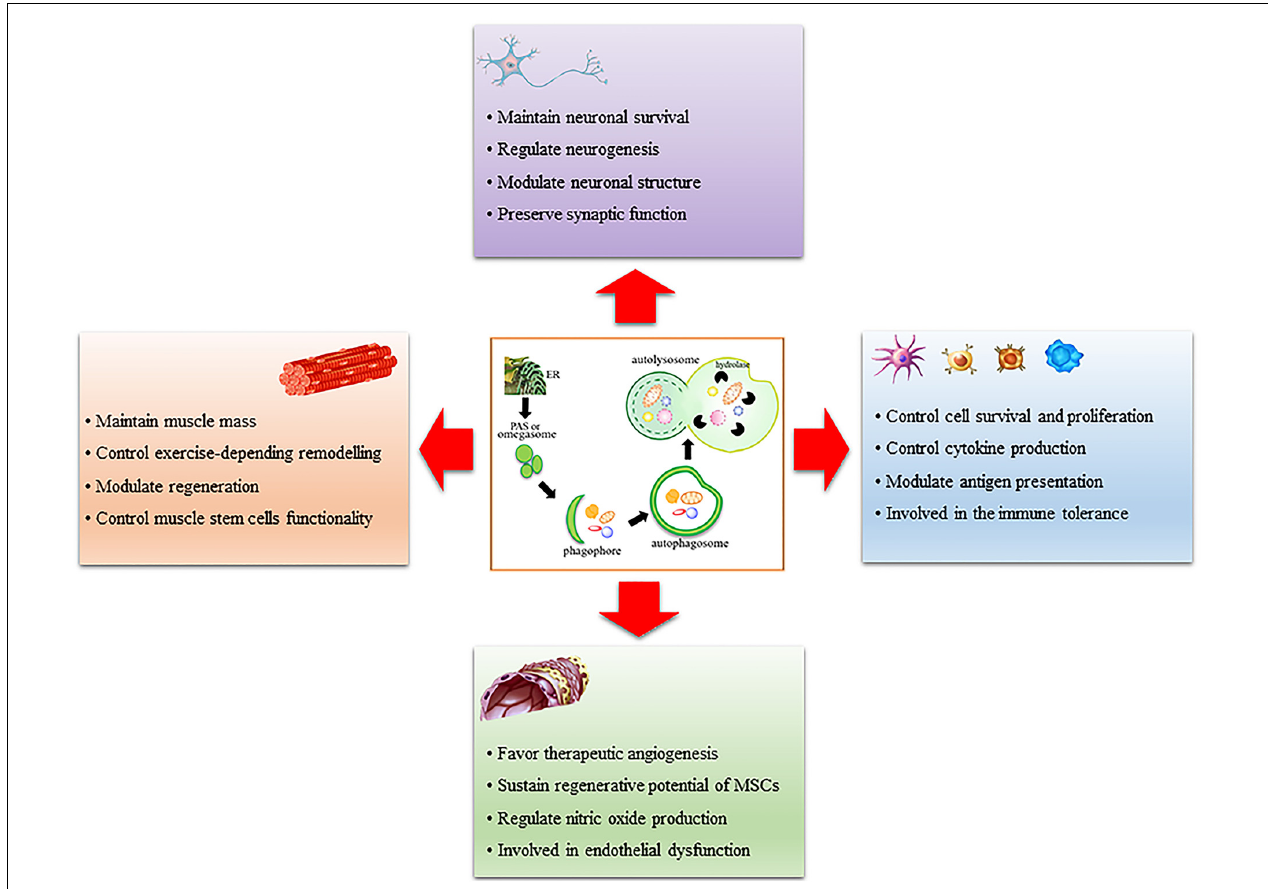
FIGURE 1 | Schematic representation of the role of autophagy in muscle, immune system, endothelium, and brain. Autophagy is a multi-step process that involves phagophore formation from the endoplasmic reticulum-associated structure called omegasome or phagophore assembly site (PAS). This structure grows around the material to be eliminated and forms a characteristic double-membrane vesicle called autophagosome. Mature autophagosome fuses with lysosomes to form autolysosome wherein the material is digested by lysosomal hydrolases. Autophagy regulates many functions in each tissue analyzed, it is important for their remodeling after stimuli or stress conditions and it is altered in many pathologic